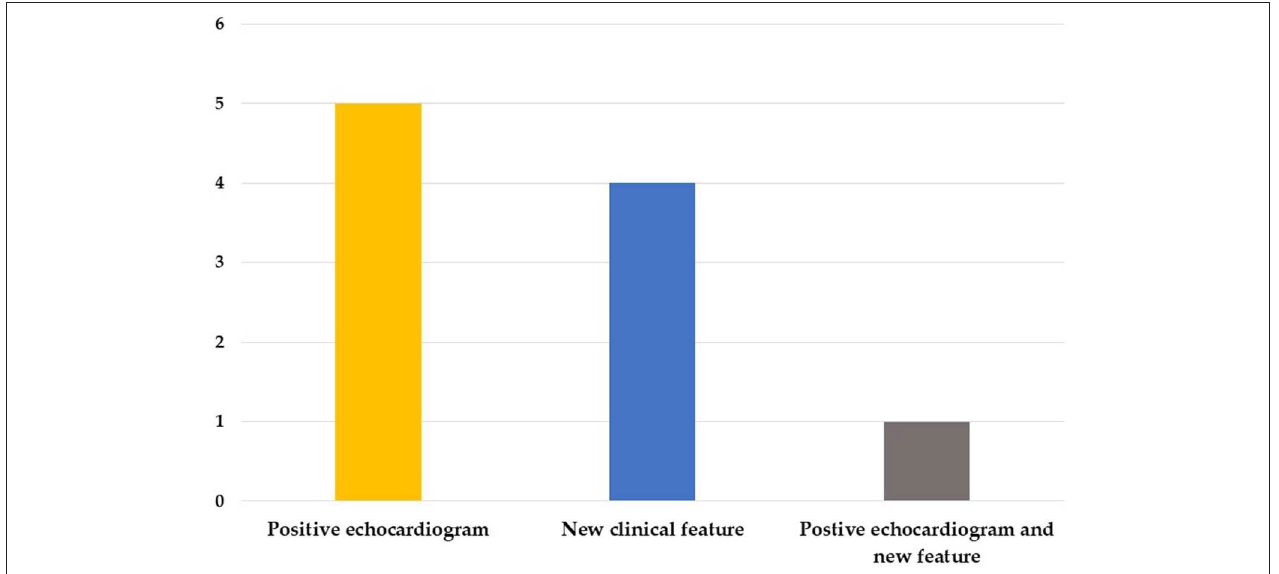
FIGURE 1 | Factors for diagnosis of KD based on the second visit.